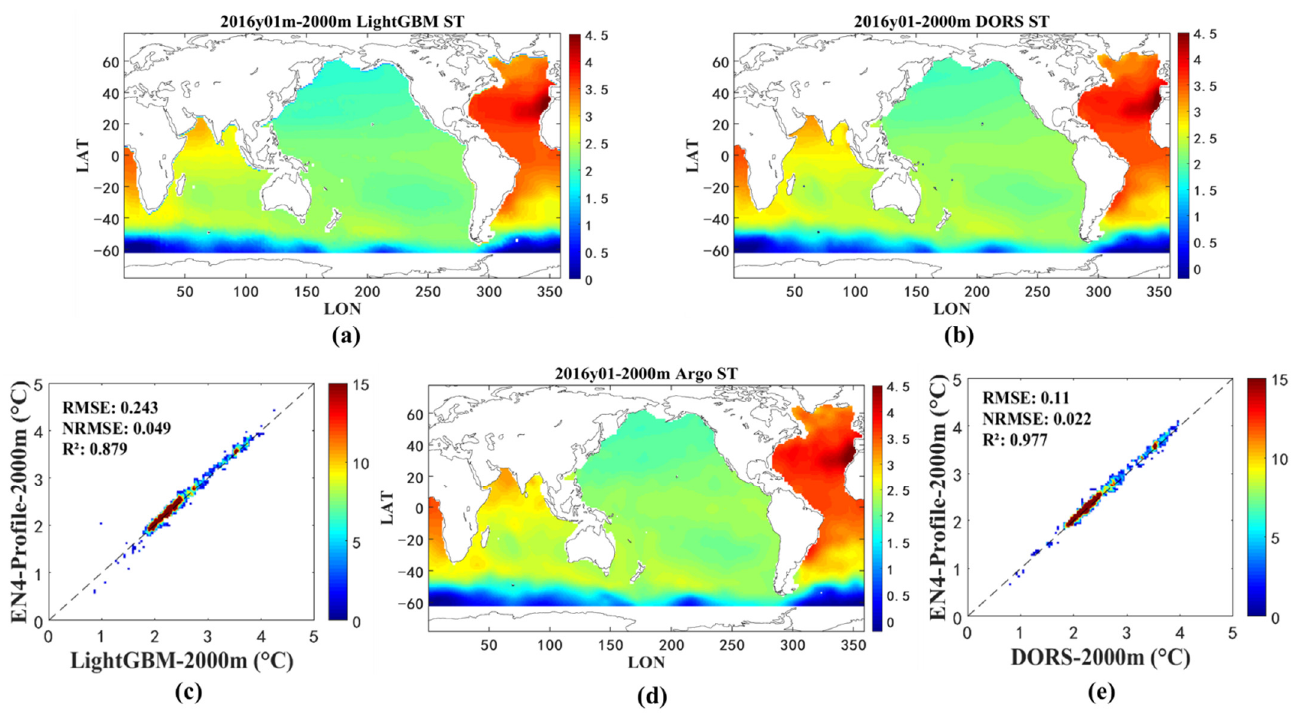
Figure 7. The spatial distribution of DORS, LightGBM, and Argo at 1000 m for January 2016, and intensity scatter plots: ( a ) is the LightGBM ST, ( b ) is the DORS ST, ( c ) is the intensity scatter plots between the LightGBM ST and the EN4-Profile ST, ( d ) is the Argo ST, and ( e ) is the intensity scatter plots between the DORS ST and the EN4-Profile ST.